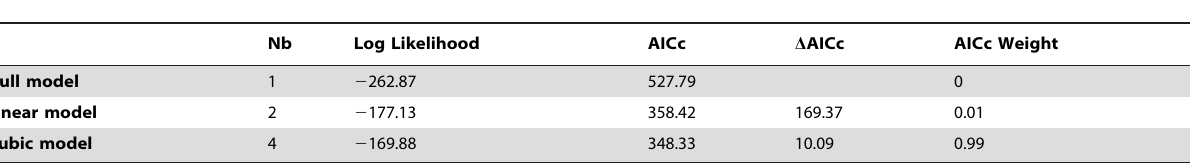
Table 2. Comparison between the null, linear and cubic